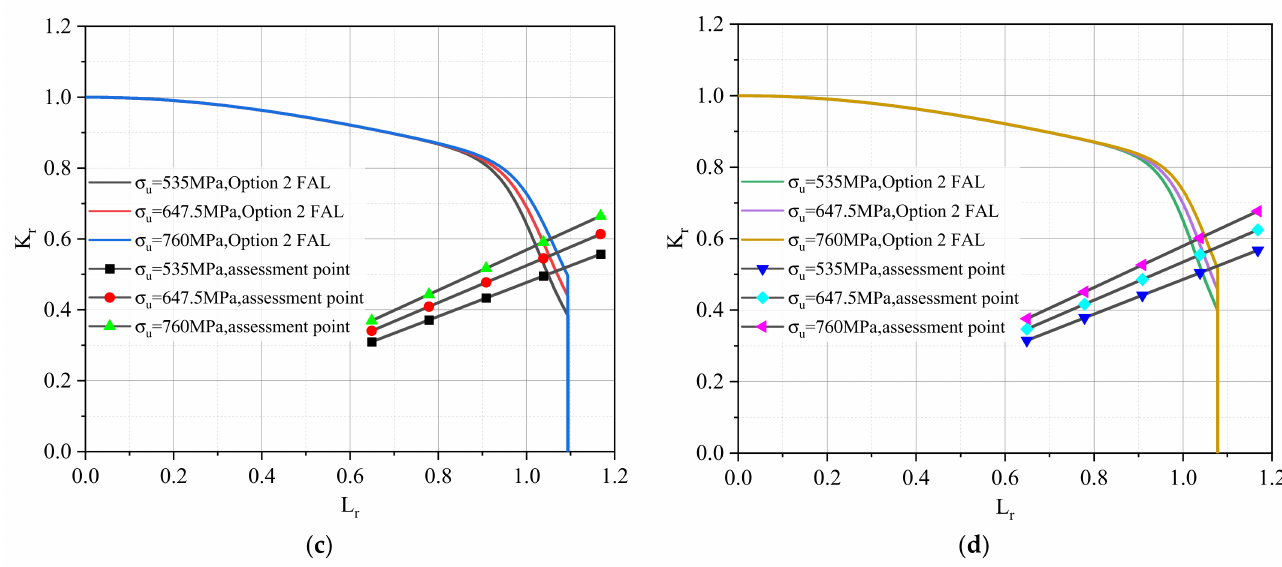
Figure 10. Effect of material properties on the evaluation results of a circumferential weld crack on the Ø813 × 11 mm pipeline. ( a ) σ u = 535 MPa (minimum value); ( b ) σ u = 647.5 MPa (mean value); ( c ) λ = 0.842; ( d ) λ = 0.865.